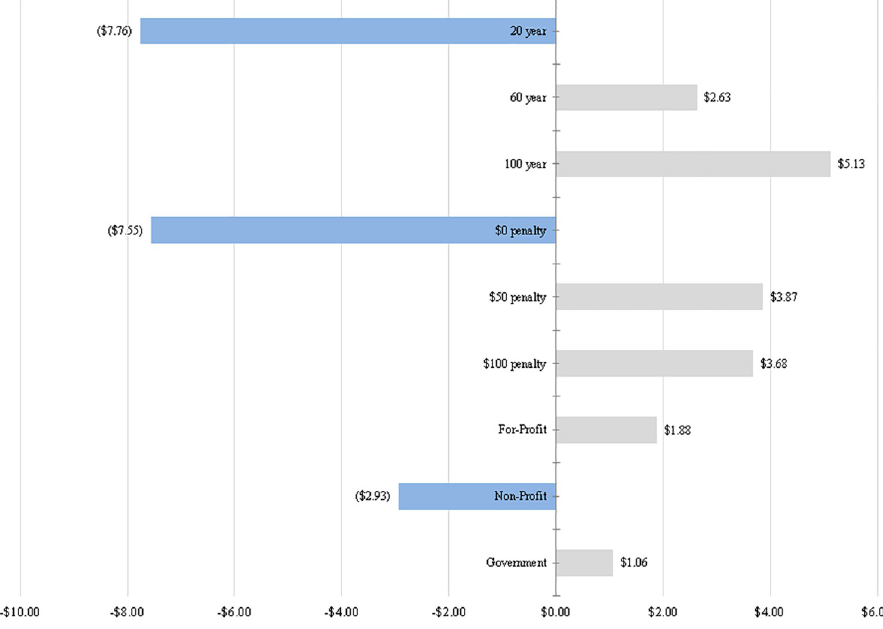
Fig 3. Willingness to accept carbon credit program feature from random effects logit model binary choice (USD per acre per year/choice).